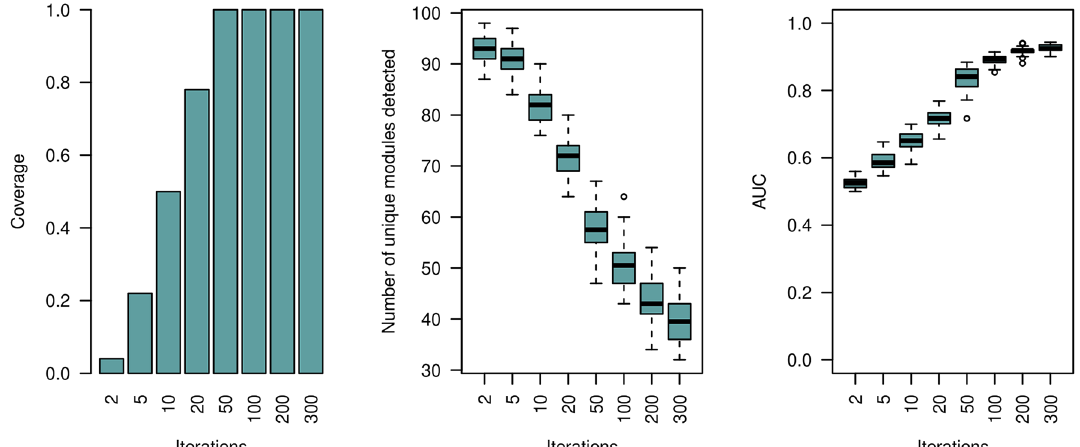
Figure 3. Single-Modal simulation results on Barabasi networks. We varied the number of greedy iterations ( n . iter ) and calculated the number of times the selected module is ranked first according to our proposed module importance score IMP m (left panel). Displayed are the number of unique modules within the n . tree module set after termination of the greedy process (middle panel). The out-of-bag performance of the Greedy Decision Forest classifier is shown in the right panel. For each run the topology of the Barabasi network, the feature values, and the selected subnetwork is the same. The simulated Barabasi networks comprise of 50 nodes.